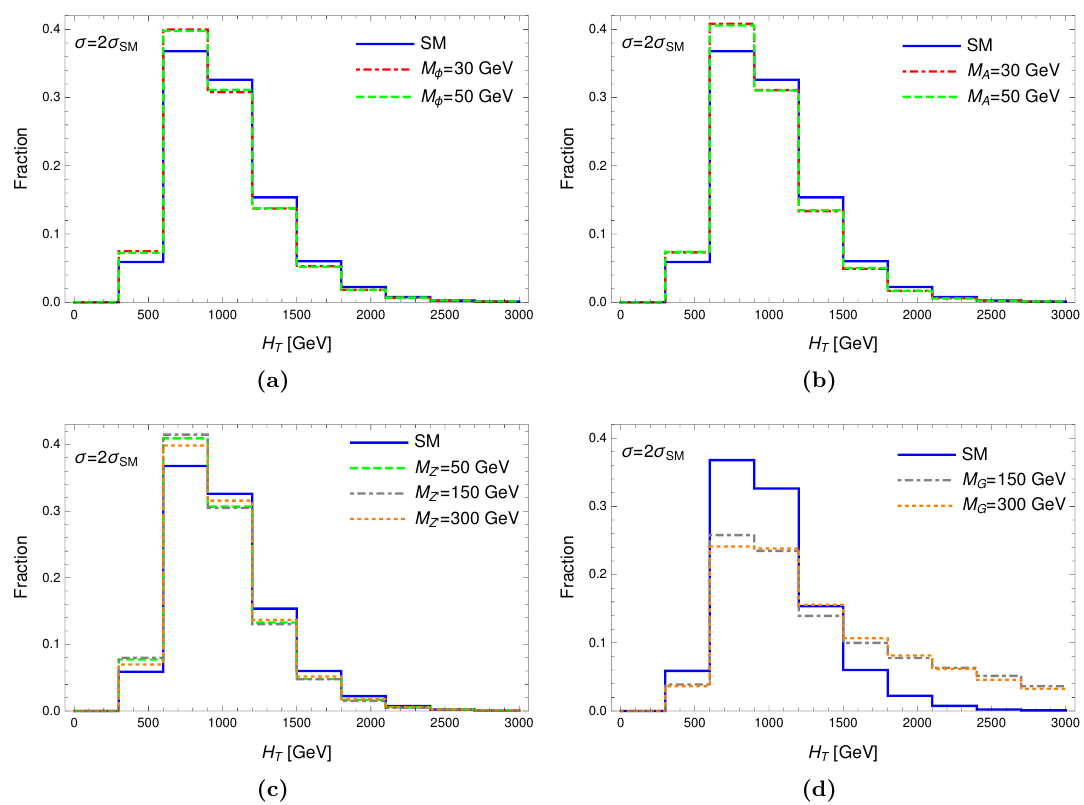
Figure 8. Distribution of the H T variable for the 2LSS channel after preselection (see text for details), normalized to unit area. Shown are the predictions for the SM (blue) and the loose benchmark points (i.e. giving (cid:27) = 2 (cid:27) SM ) of the NP models considered: (a) Scalar, (b) Pseudo- scalar, (c) Z 0 , and (d) Graviton. The distinctive behavior in the Graviton is due to the symmetry in one of its main Feynman diagram, as explained in the text. Analogous results for tight benchmark points are shown in (cid:12)gure